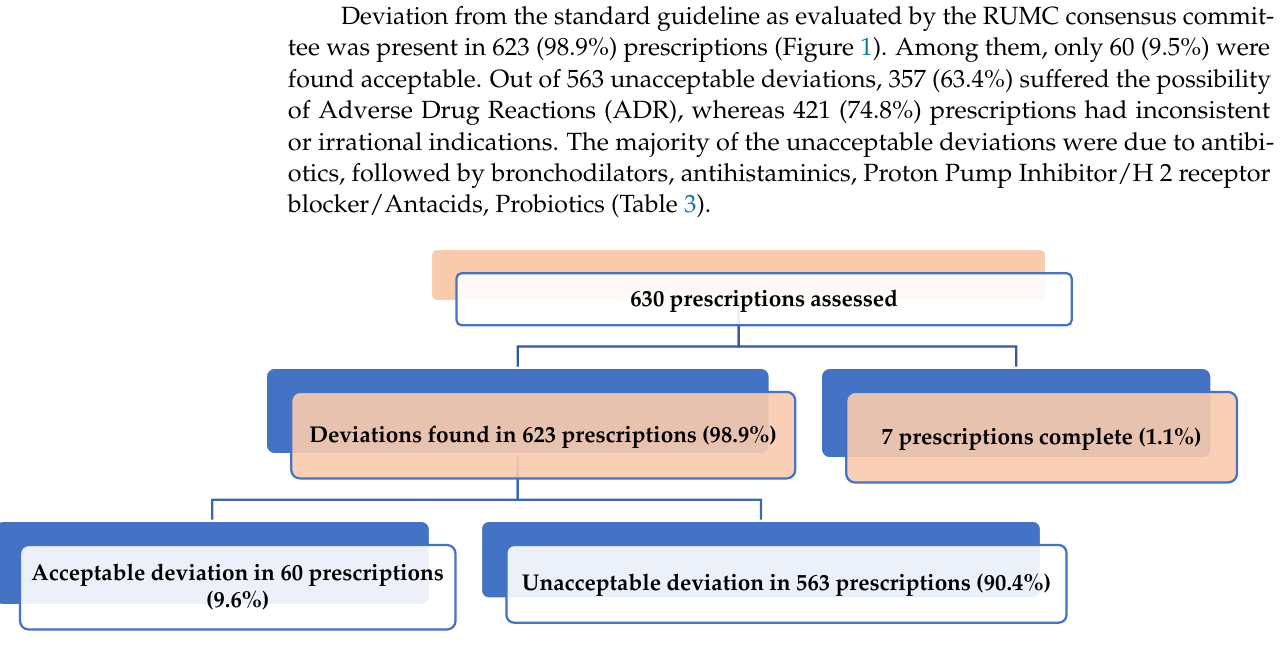
Deviations found in 623 prescriptions (98.9%)